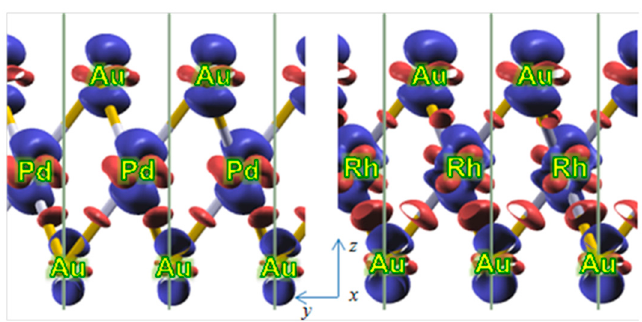
Figure 3. Charge density difference after the formation of a whole underlayer of Pd ( left ) and Rh ( right ) below the surface of Au(111) slab as obtained from Equation (5). Isosurface equal to 0.004 e · Å − 3 . Red and blue colors correspond to electron accumulation and depletion, respectively.